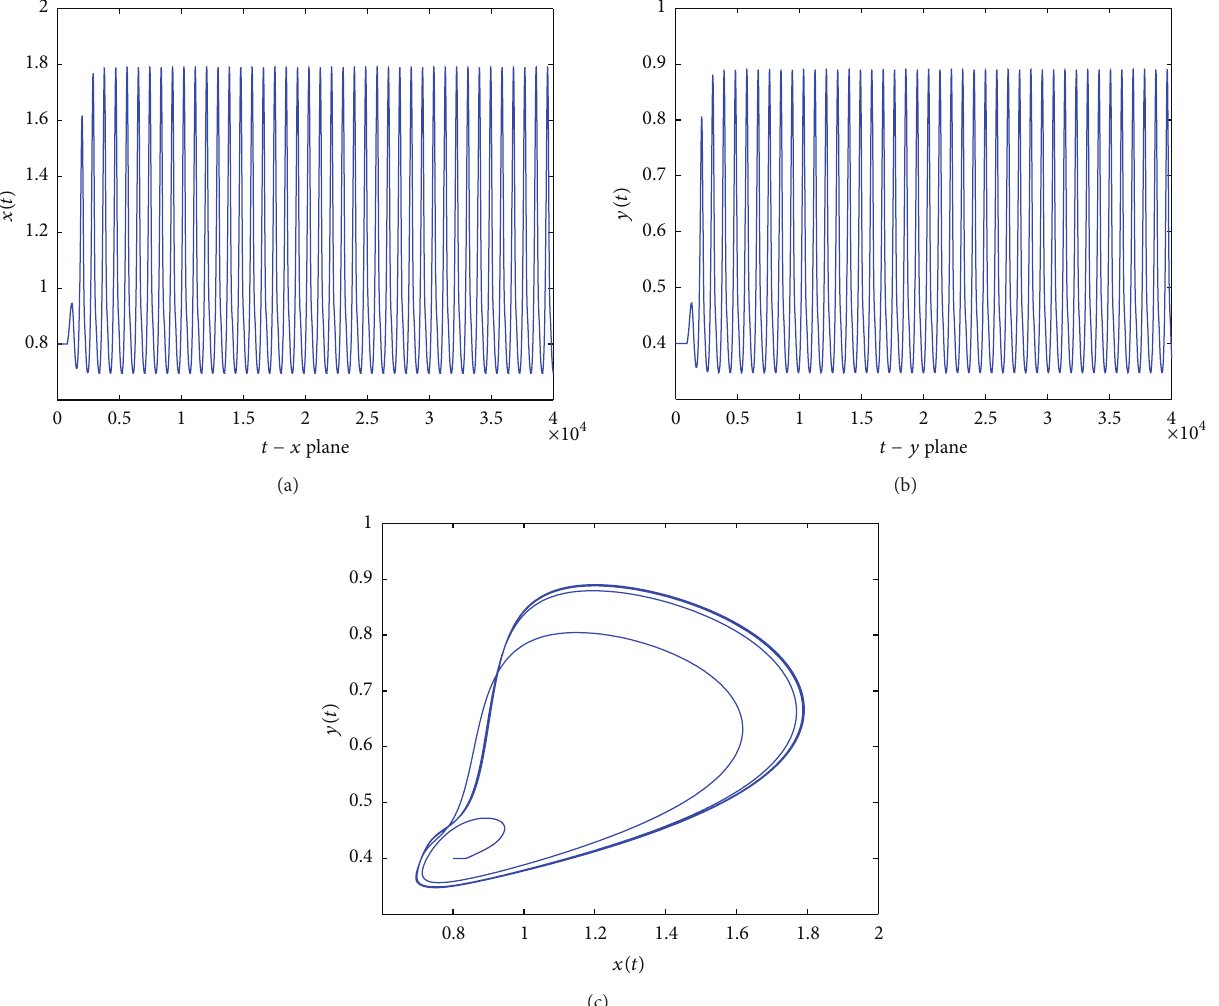
Figure 4: The trajectories and phase graphs of system (1) with 𝜏 = 𝜏 1 + 𝜏 2 = 10 + 8 = 18